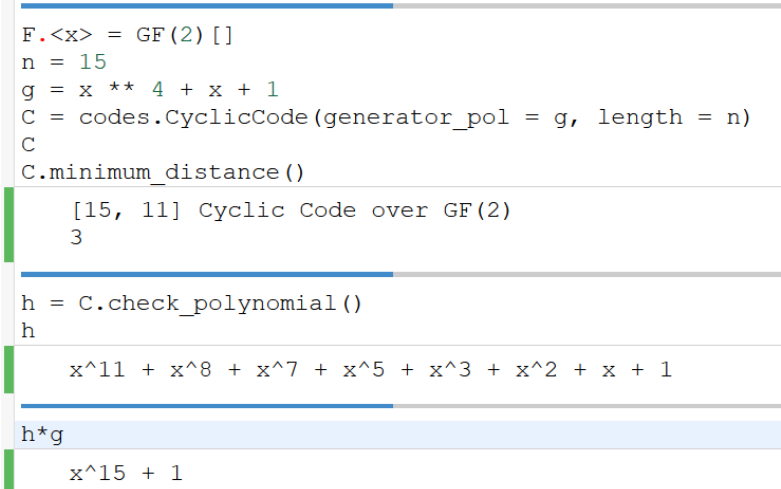
Figure 15. Defining a cyclic